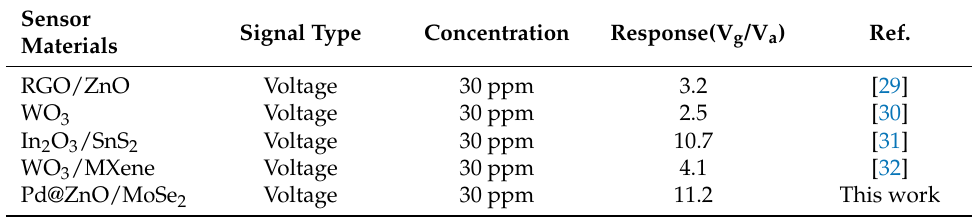
Table 1. Comparison of various NO 2